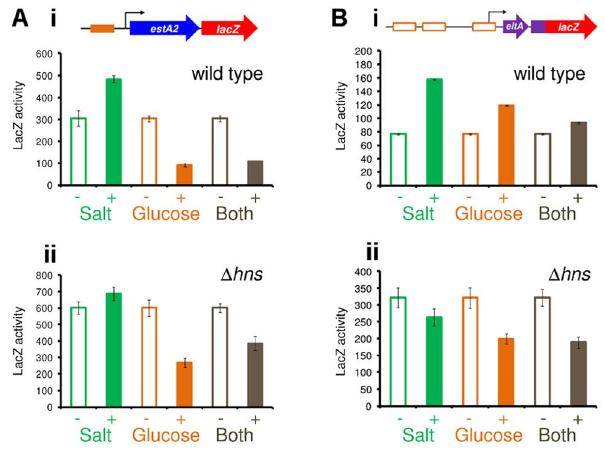
Fig. 8. H-NS and CRP integrate signals of osmolarity and metabolism to control expression of LT and ST. The figure shows b -galactosidase activity measurements for lysates obtained from cultures of M182 (i) or the D hns derivative (ii) containing A) P estA2 or B) P eltAB fused to lacZ in plasmid pRW50. Cultures were grown in the presence and absence of 2% glucose and/or salt (60 mM NaCl and 20 mM KCl). Assays were done in M9 minimal medium so that the glucose and salt concentrations could be more accurately controlled.